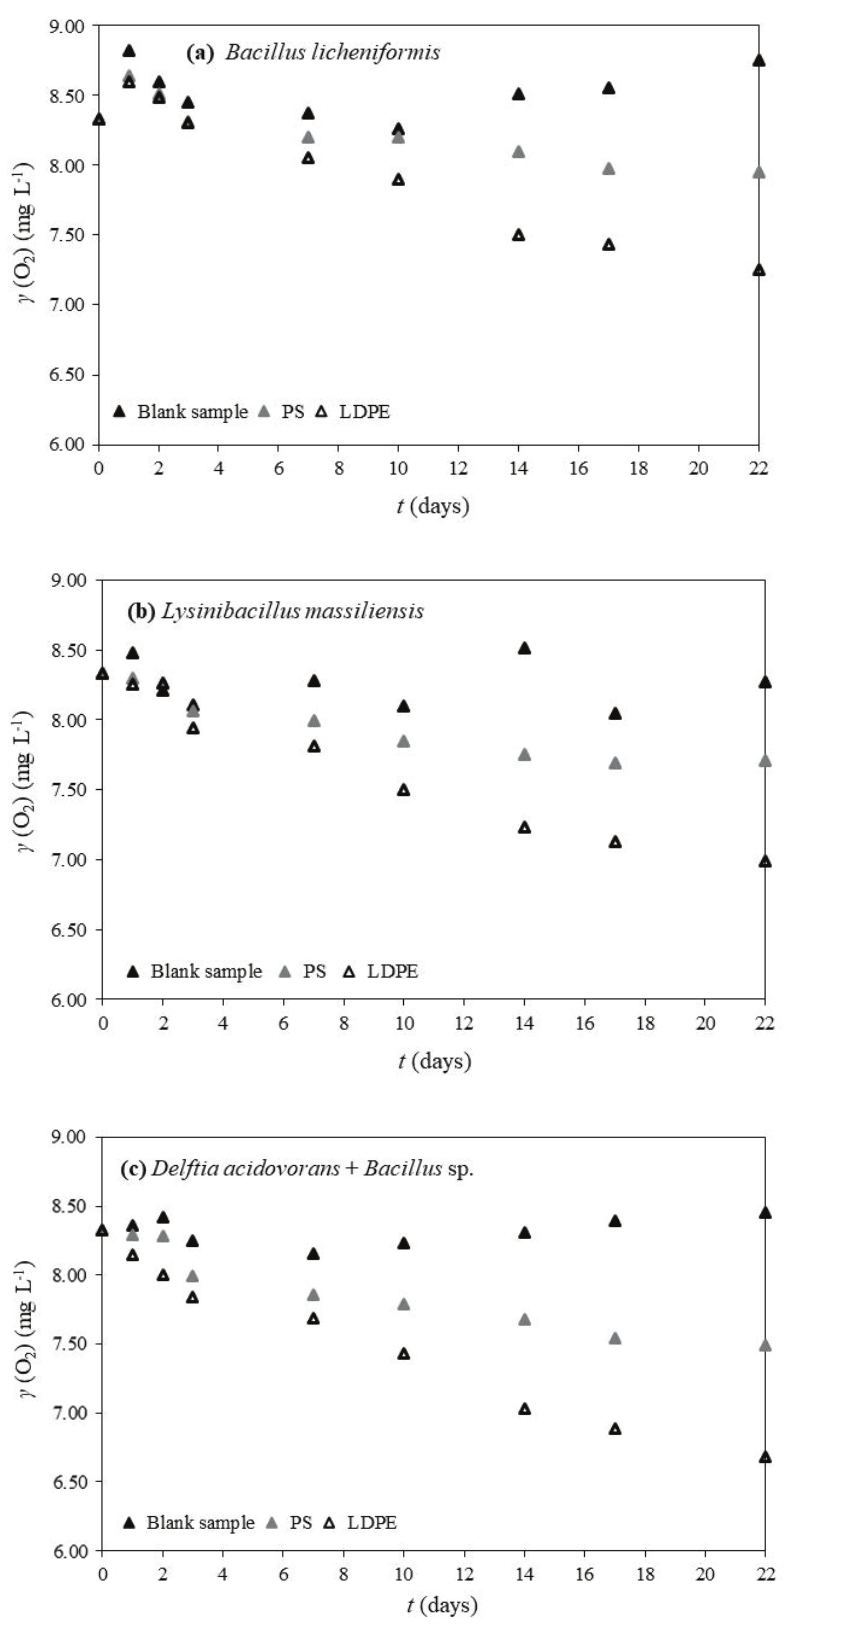
Fig. 4 – Changes in concentration of dissolved oxygen during biodegradation of MP-LDPE and MP-PS with bacterial culture Ba- cillus licheniformis (a), Lysinibacillus massiliensis (b), and mixed bacterial culture of Bacillus sp. and Delftia acidovorans (c) in sterile Erlenmeyer flasks during 22 days (Vr = 100